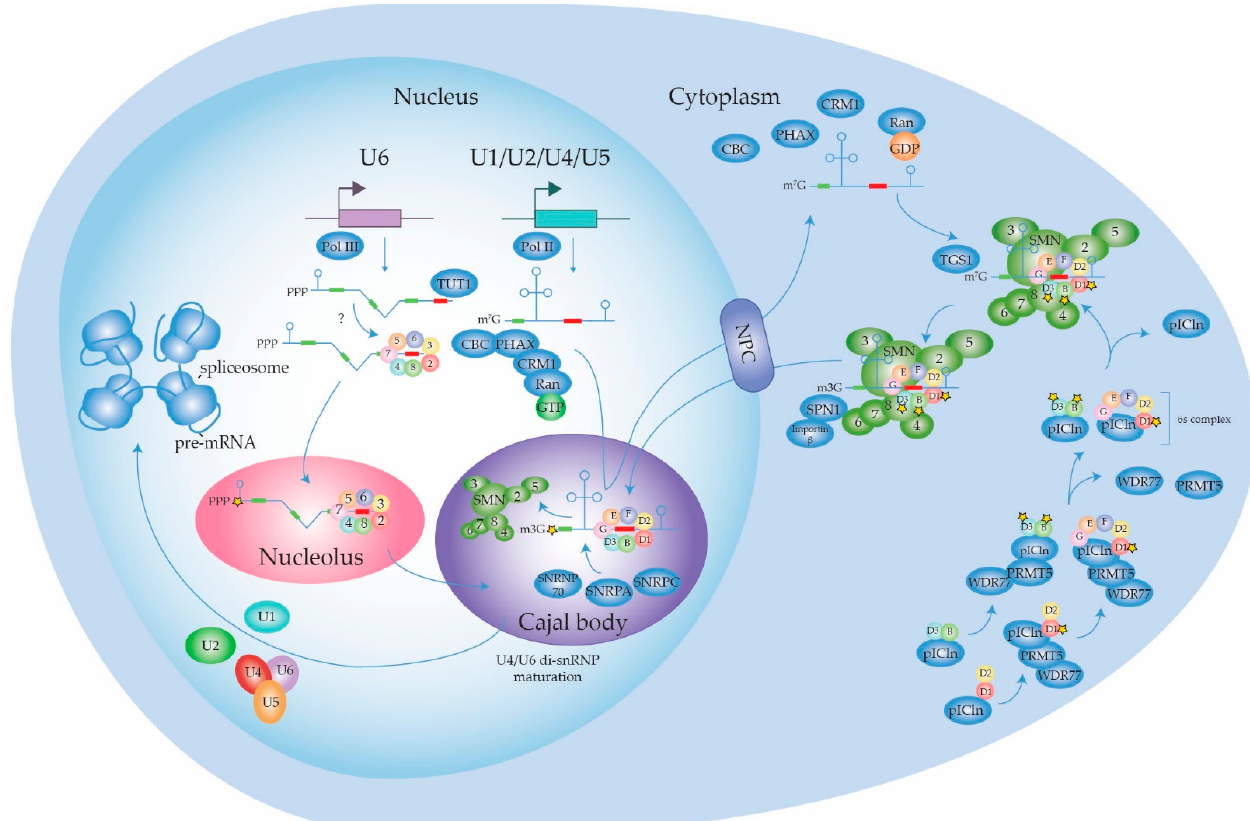
Figure 2. Spliceosome snRNP subunit biogenesis. Details are given in the main text. Since U1, U2, U4 and U5 snRNPs are compiled in the same manner, the biogenesis of U1 snRNP is shown as example. The snRNAs are transcribed by either RNA polymerase II (U1, U2, U4, U5) or RNA polymerase III (U6). RNA polymerase II-transcribed snRNA is exported to the cytoplasm after quality control in Cajal bodies (CBs). SmD1, SmD3 and SmB/B’ are dimethylated (displayed by stars) in the cytoplasm by the methylosome complex. The Sm ring is assembled around the snRNA by the SMN complex and the Sm-snRNA core complex is imported back into the nucleus where snRNP maturation takes place in the CBs. The exact LSm assembly route onto the U6 snRNA is not known but presumably takes place in the nucleus. The LSm-U6 snRNA core complex probably moves to the nucleolus where it is 2-O’-methylated (displayed as a star) and subsequently transported to the CBs where U6-specific proteins are assembled and U4/U6.U5 tri-snRNP maturation can take place. Mature snRNPs are recruited into the supraspliceosome to take part in the RNA splicing reaction.